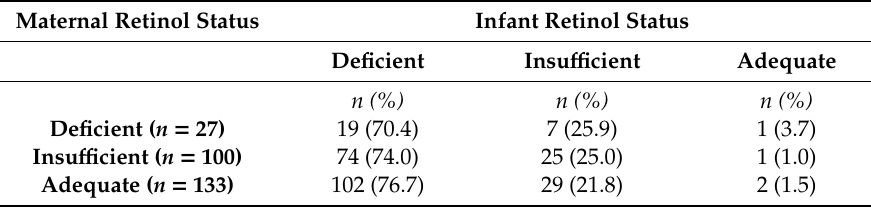
Table 4. Proportion of infant retinol status by maternal retinol category.